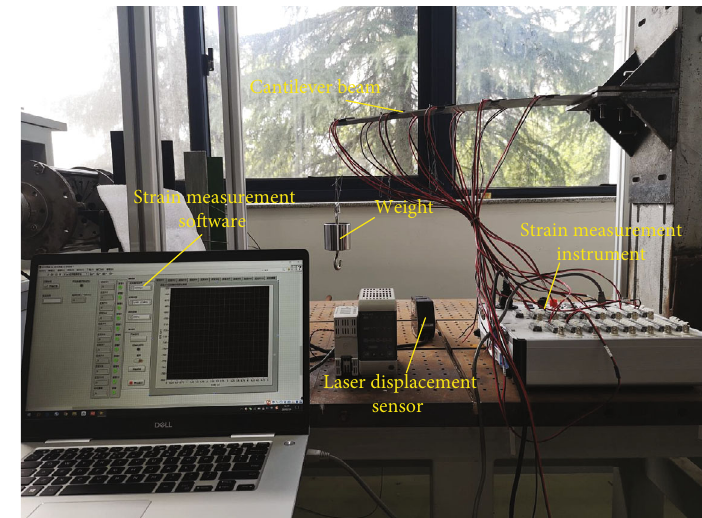
Figure 5: The whole experimental system.